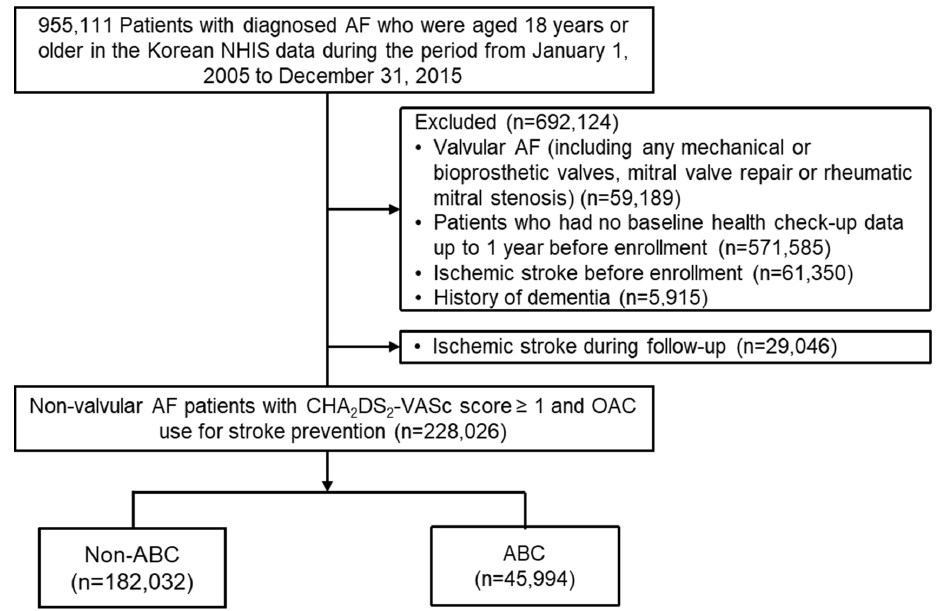
Figure 1. Flowchart of study population enrolment. ABC, atrial fibrillation better care; AF, atrial fibrillation; OAC, oral anticoagulant; NHIS, National Health Insurance Service.